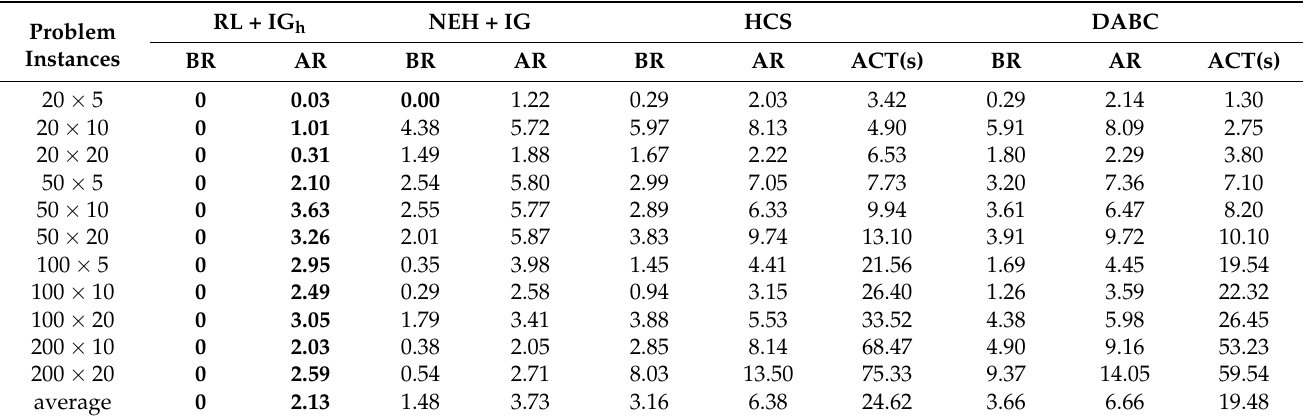
Table 6. Comparison of RL + IG h and multiple meta-heuristic algorithms.